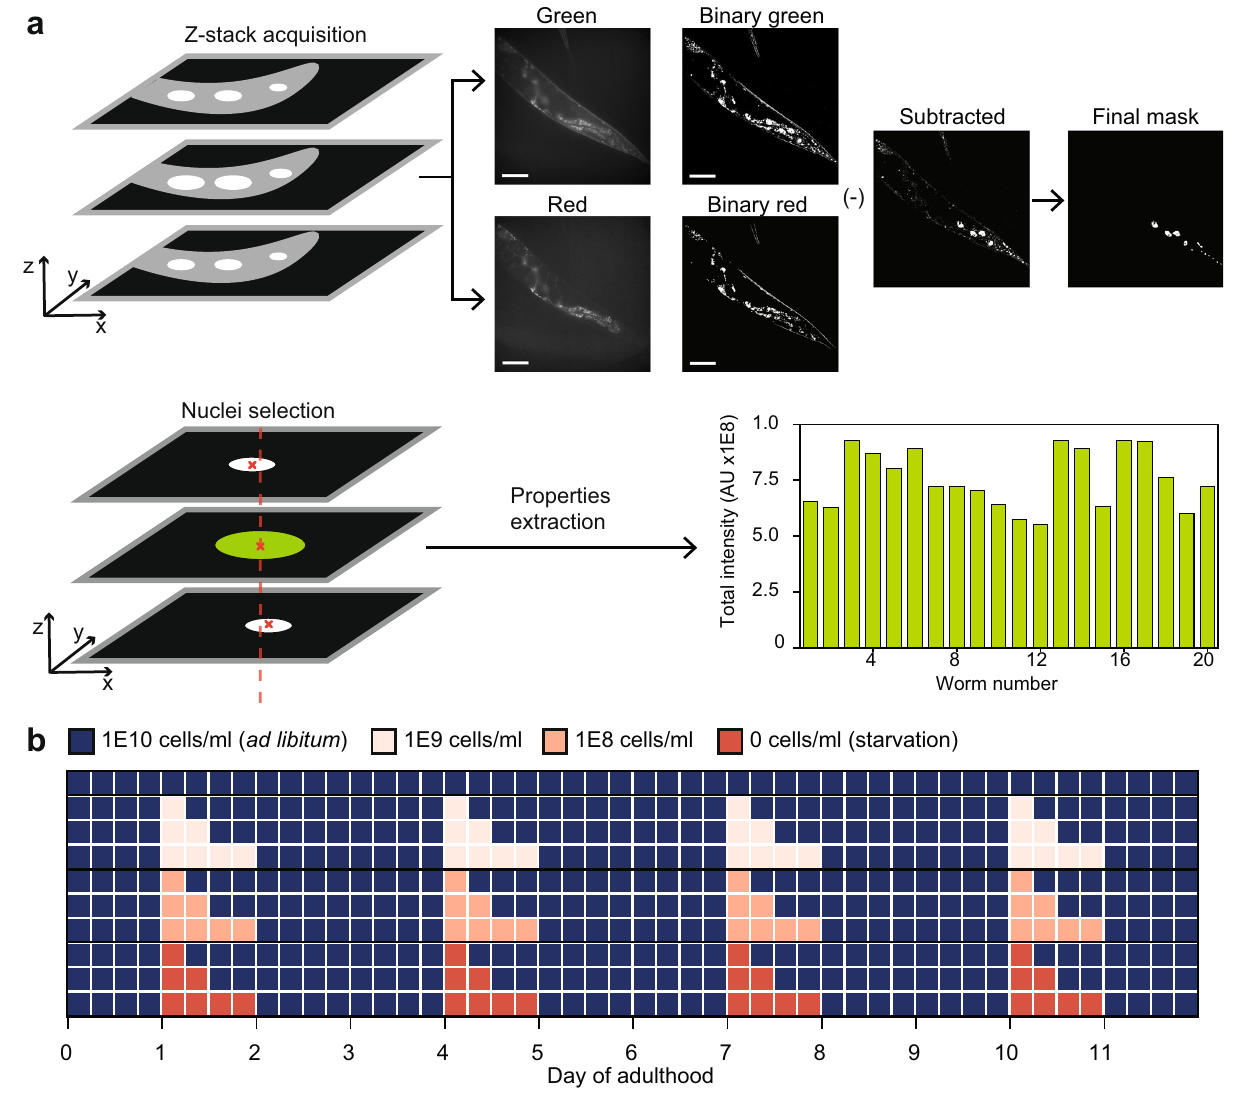
Fig. 1 Quantitative analysis of endogenous DAF-16 under dietary restriction regimes. a Four Z-stacks of 30 slices are taken of each animal. Each slice in the green channel has a corresponding red channel slice. Both are converted to binary images and subtracted from each other to eliminate auto fl uorescence. The resulting image is treated with morphological functions and objects are fi ltered based on extent, solidity, and eccentricity. An image containing only cell nuclei is obtained, and largest nuclei are retained if they appear in several slices. Pixel-based intensity is then aggregated to obtain total DAF-16 intensity in all of the animal ’ s identi fi ed nuclei. b Diagram of DR regimes tested in this study. Animals were exposed to three levels of DR: 1E9, 1E8, or 0 OP50 cells/ml; for three exposure times: 6, 12, or 24h. After each exposure, animals were put back in an ad libitum concentration (1E10 OP50 cells/ml). Exposure to DR was performed at Days 1, 4, 7, and 10 of adulthood. Scale bars are 50 µ